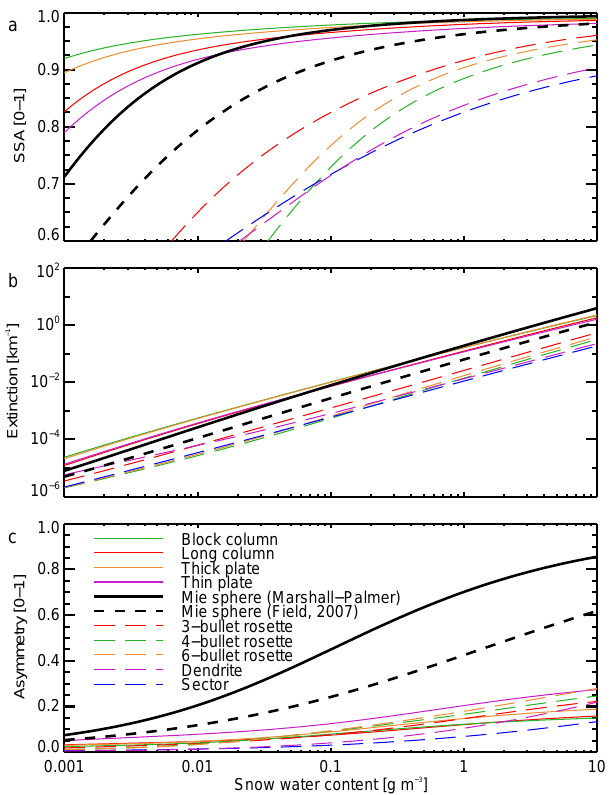
Figure 2. Bulk optical properties at 52.8GHz and 253K, as a func- tion of snow water content. Optical properties of the Liu (2008) shapes have been computed with the Field et al. (2007) size distri- bution. Some Liu (2008) shapes have similar bulk scattering prop- erties to others and are ignored: the five-bullet rosette is similar to the six-bullet; the short column is similar to the thick